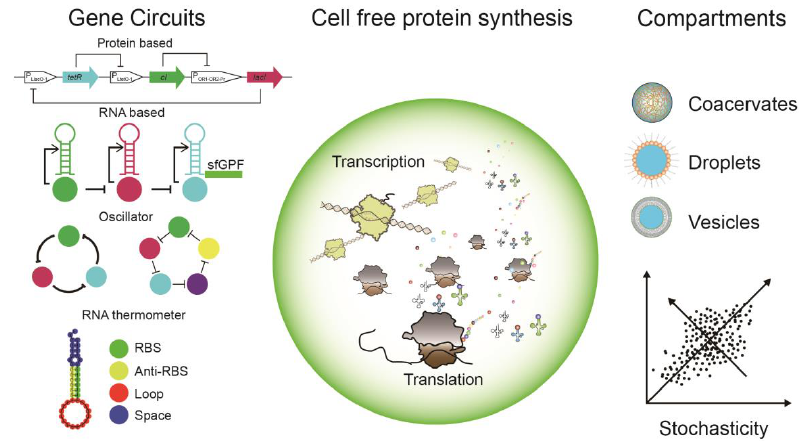
Figure 1. Cell-free protein synthesis (CFPS) within various compartments and its regulation via gene circuits. The CFPS system hosts the core transcription and translation processes, providing the chassis/framework for different cellular mimicry modules/systems. A number of regulatory elements were introduced and validated to manipulate the protein synthesis within CFPS systems. Both RNA and protein-based gene circuits were built to regulate target protein expression on the transcription level via tuning corresponding mRNA concentration. With such design principles, large genetic networks were successfully realized, i.e., 3- and 5-node ring oscillators. On the translational level, RNA thermometers were employed and were able to control translation initiation via tuning the availability of the ribosomal binding sites (RBS). Different materials were applied for creating the physical boundary to encapsulate the CFPS reactions, including coacervates, water in oil droplets, and lipid vesicles. System stochasticity starts to influence the output of gene expression when CFPS reactions were encapsulated. RBS: ribosomal binding site; Anti-RBS: anti-ribosomal binding site; sfGFP: super folder green fluorescent protein; tetR: gene sequence coding Tet Repressor proteins; cl : gene sequence coding cl protein that binds OR1 and OR2 sites within P R promoter; lacI: gene coding lac repressor; P LlacO-1 , P LtetO-1 , and P OR1-OR2-Pr : promoter sequences that can be regulated via corresponding repressor